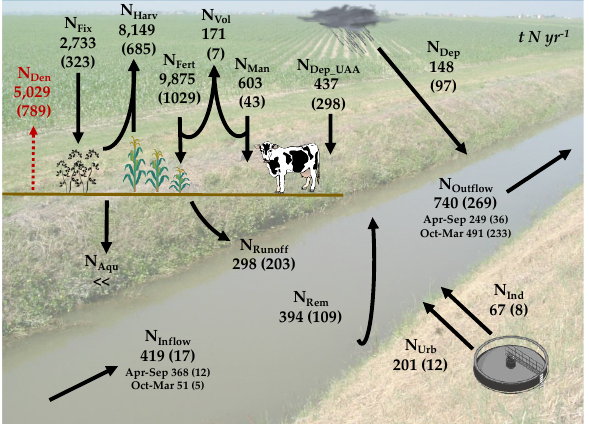
Figure 3. Schematic showing the N fluxes in the soil–water system of the Po di Volano-Sacca di Goro watershed. N input to agricultural soils: livestock manure (N Man ), synthetic fertilizers (N Fert ), biological fixation (N Fix ), and atmospheric deposition (N Dep_UAA ). N output from agricultural soils: crop harvest (N Harv ), ammonia volatilization (N Vol ), leaching to the shallow unconfined aquifer (N Aqu ), N lost in runo ff water (N Runo ff ), and denitrification (N Den ). N input to the canal network: N load imported by the canal network (N Inflow ), atmospheric N deposition on surfaces other than agricultural soils (N Dep ), N load from urban areas (N Urb ), N load from industrial areas (N Ind ), and N Runo ff . N output from the canal network: N load exported from the basin (N Outflow ) and N removed by denitrification in the canal sediments (N Rem ). All terms are expressed in t N · year − 1 (standard deviation is reported in brackets). N Inflow and N Outflow are also reported by splitting the contribution of the irrigation period (from April to September) and the non-irrigation period (from October to